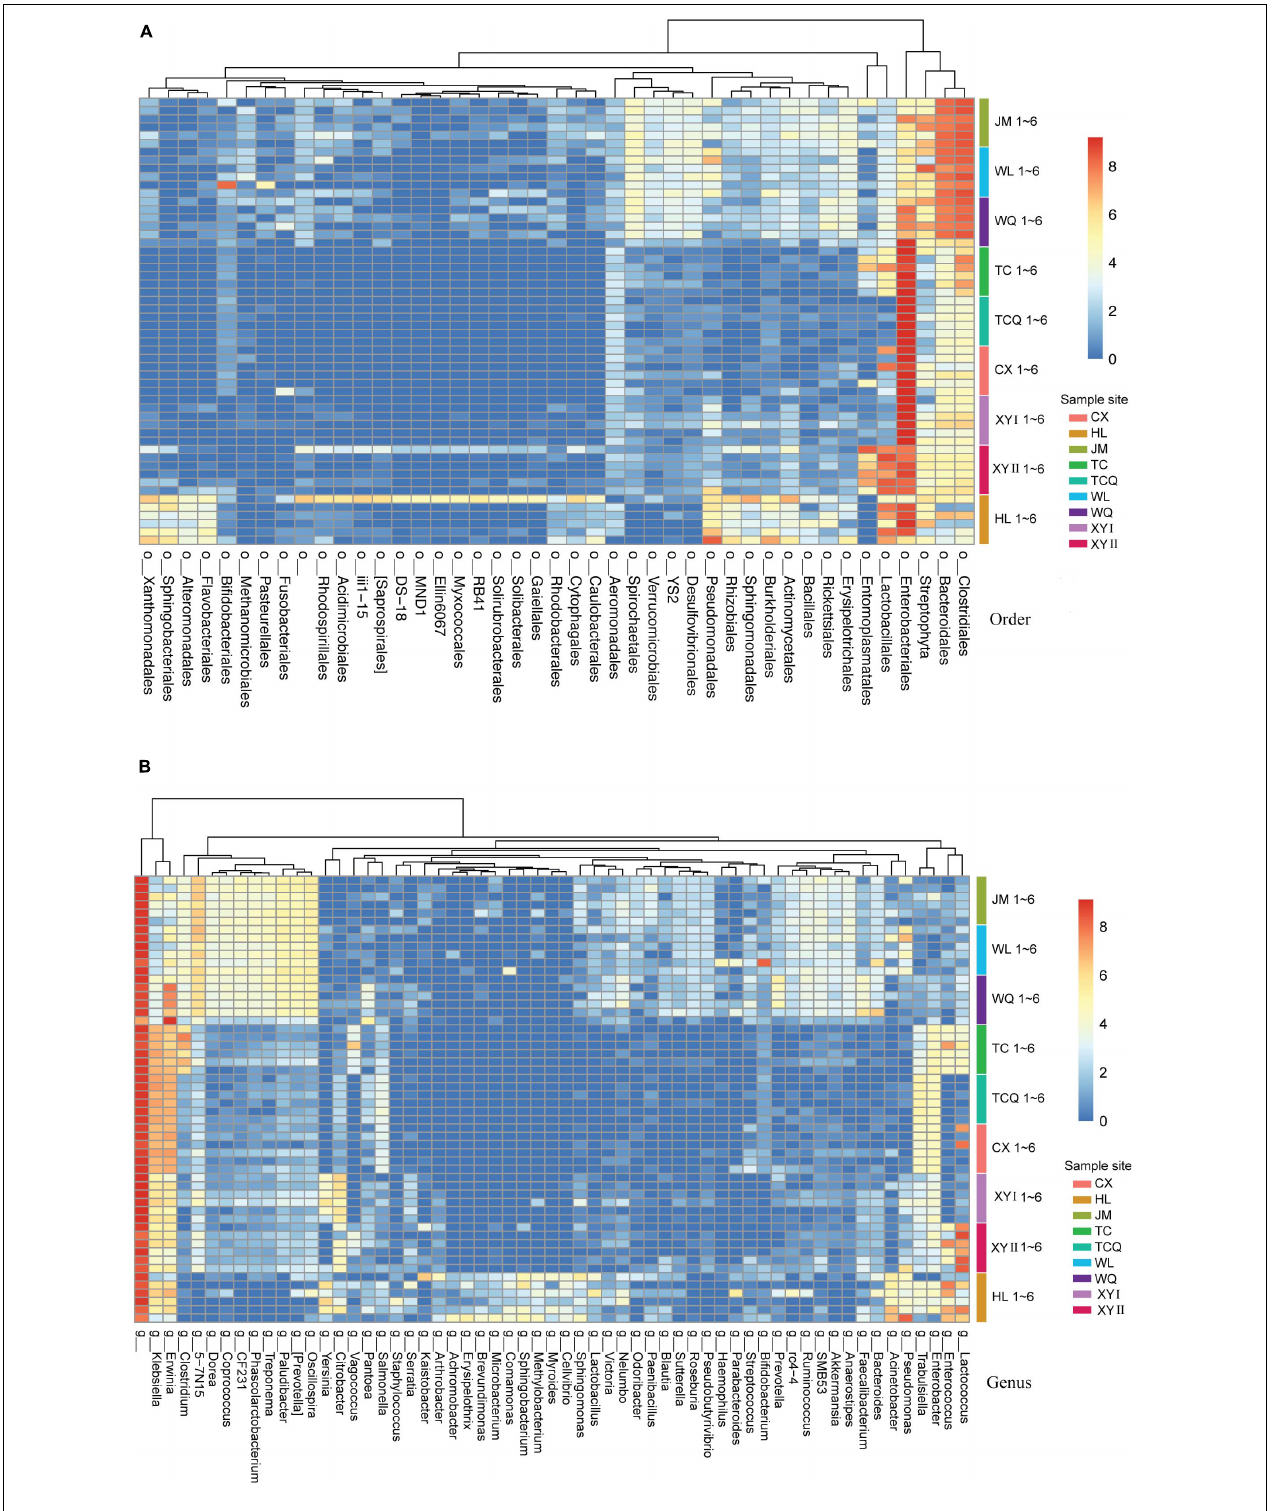
FIGURE 7 | Differences in microbes at the order/genus level for CPB from different geographical sources. Low relative abundance ( < 0.01) and unidentified order/genus microbes were grouped into o__/g__. (A) Heatmap of bacterial communities of CPB from different sites (order level). (B) Heatmap of bacterial communities of CPB from different sites (genus